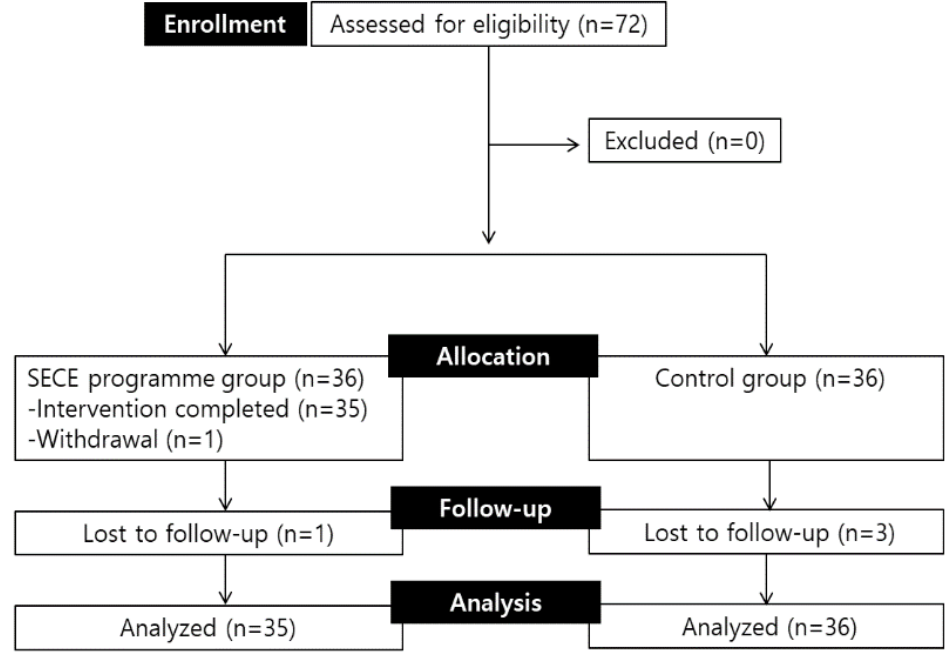
Figure 1. Flow diagram for the study. SECE—social and emotional competence enhancement.